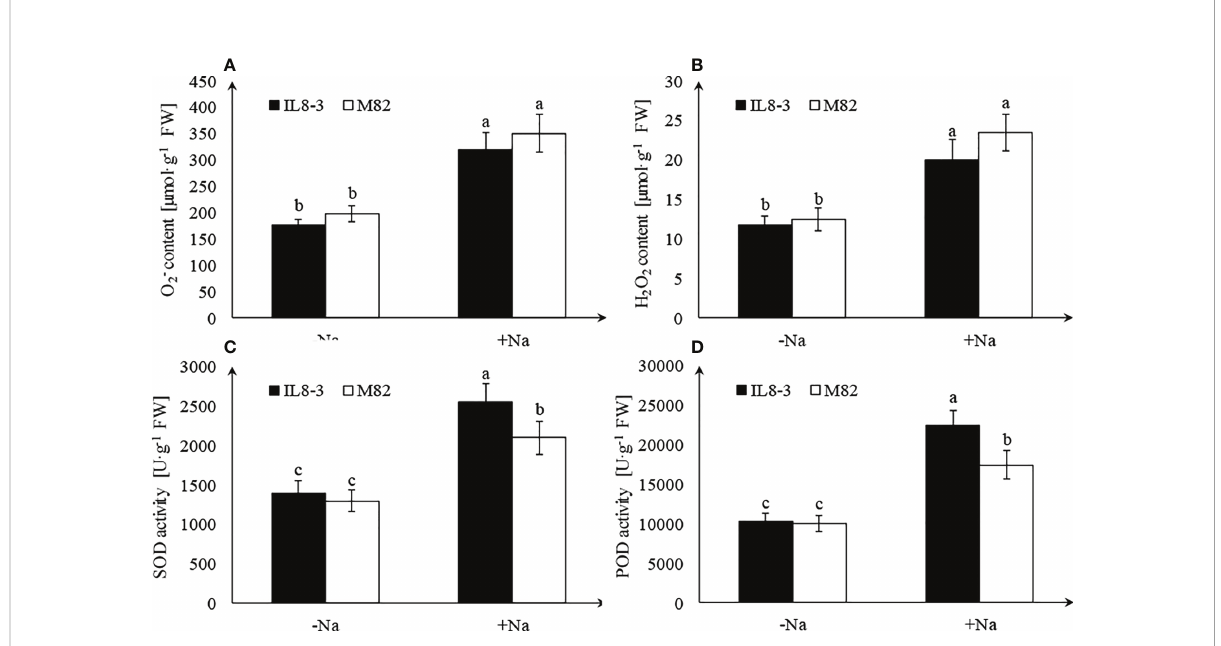
FIGURE 2 Effect of salt stress on reactive oxygen species (ROS) accumulation and antioxidant enzyme activities. O − 2 content (A) , H 2 O 2 content (B) , SOD activity (C) , POD activity (D) , under NaCl-free condition (-Na) and 200 mM NaCl stress (+Na). Values represent the mean ± SD of four independent replicates, bars with different letters show signi fi cant differences (ANOVA, LSD, P<0.05).